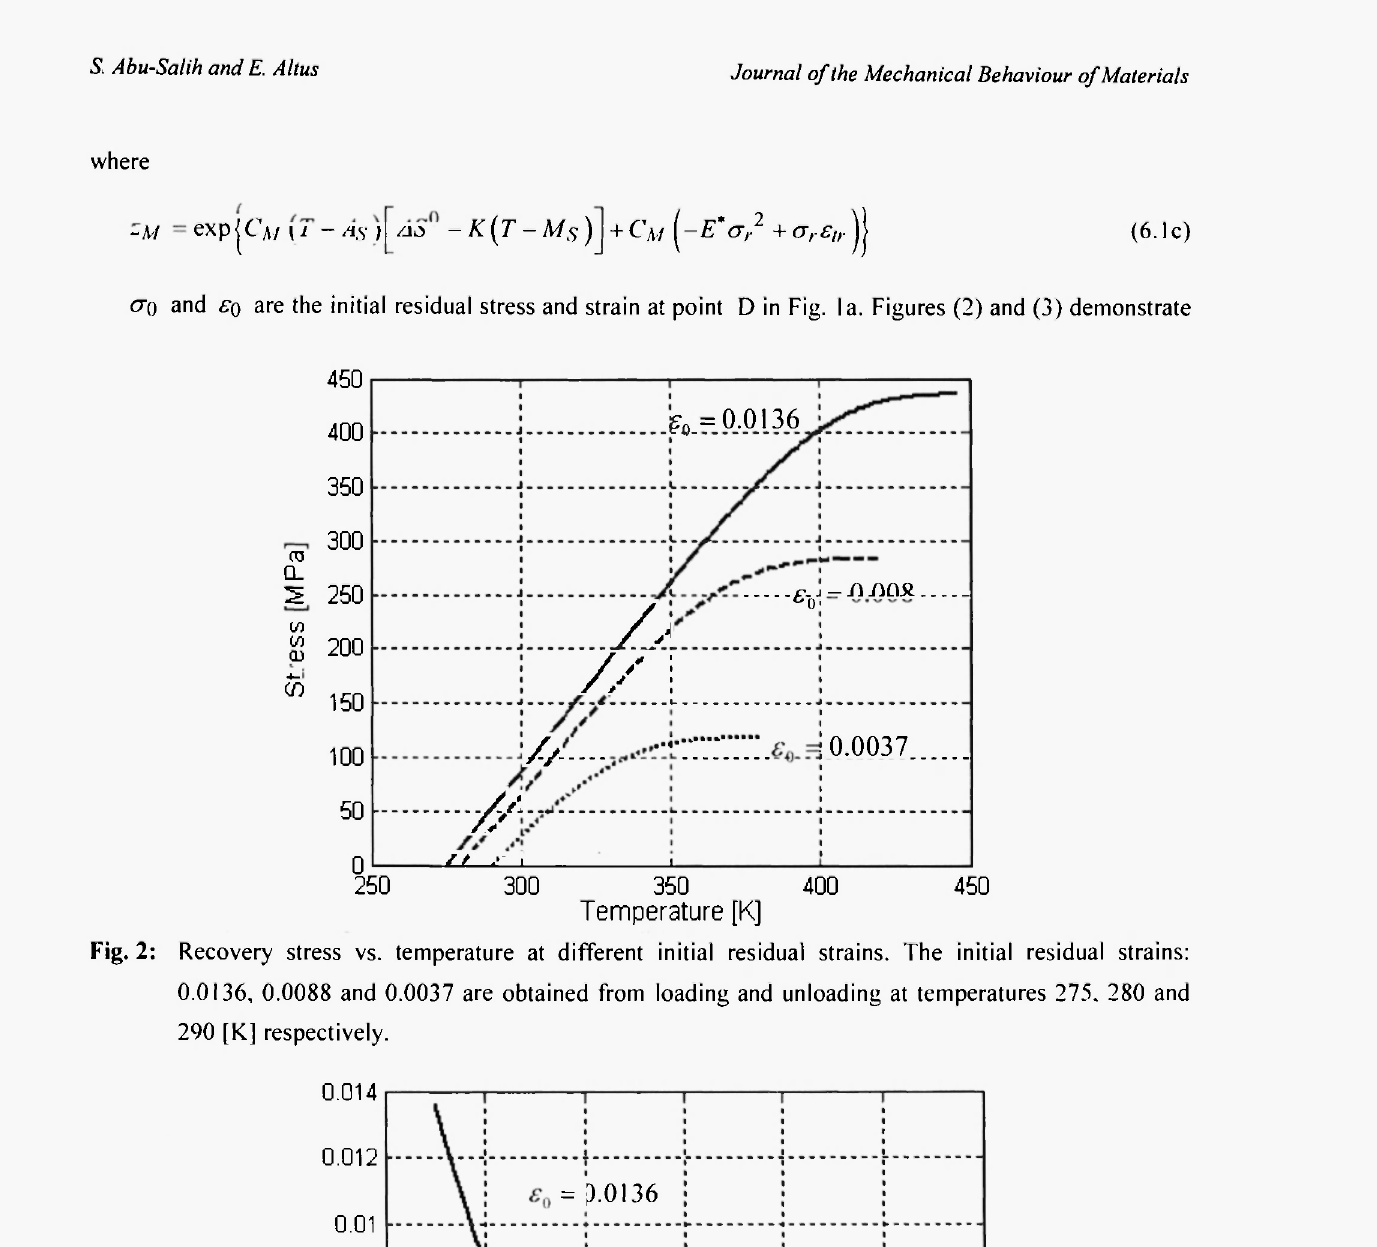
Recovery stress vs. temperature at different initial residual strains. The initial residual strains: 0.0136, 0.0088 and 0.0037 are obtained from loading and unloading at temperatures 275. 280 and 290 [K] respectively.